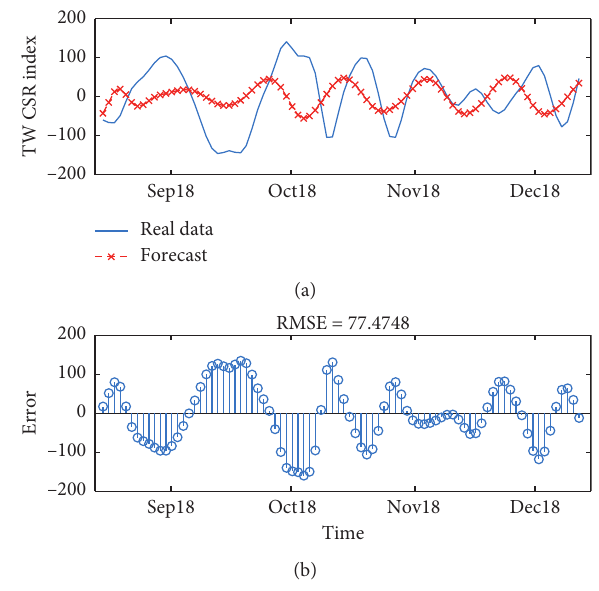
Figure 10: LSTM prediction and actual verification results for IMF2 with RMSE of 77.4748.